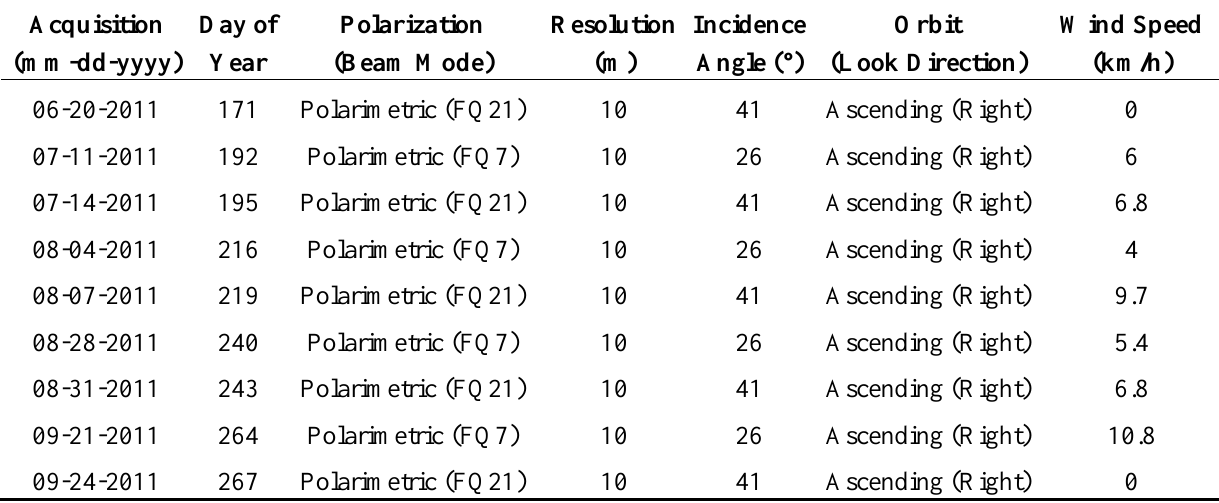
Table 1. 2011 RADARSAT-2